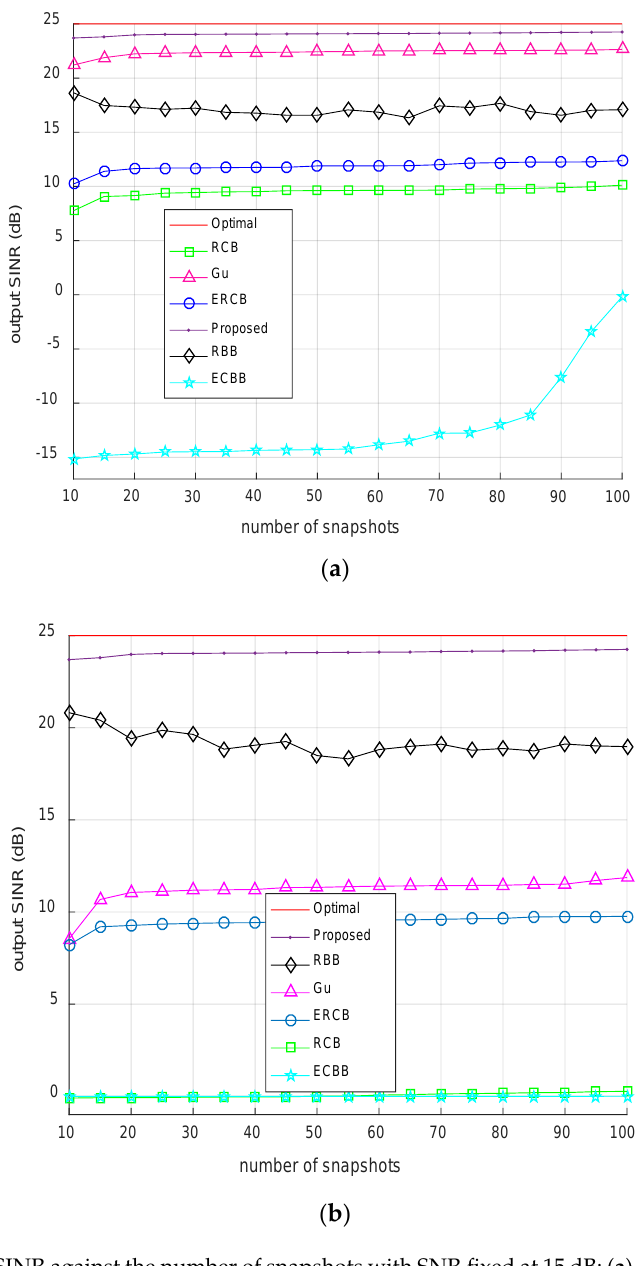
Figure 4. Output SINR against the number of snapshots with SNR fixed at 15 dB: ( a ) Incoherent sources; ( b ) Coherent sources.